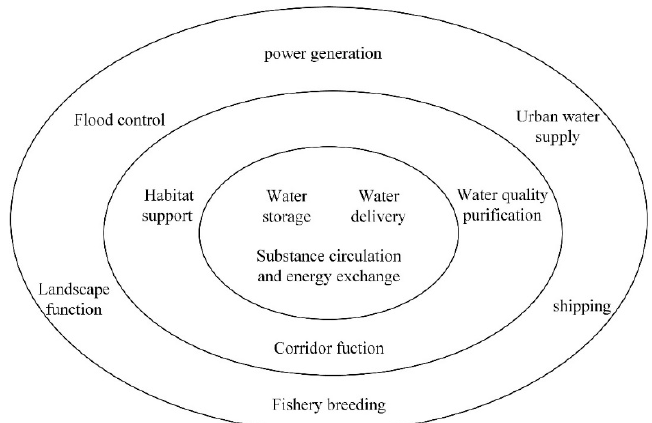
Figure 3. Classification of urban river function.